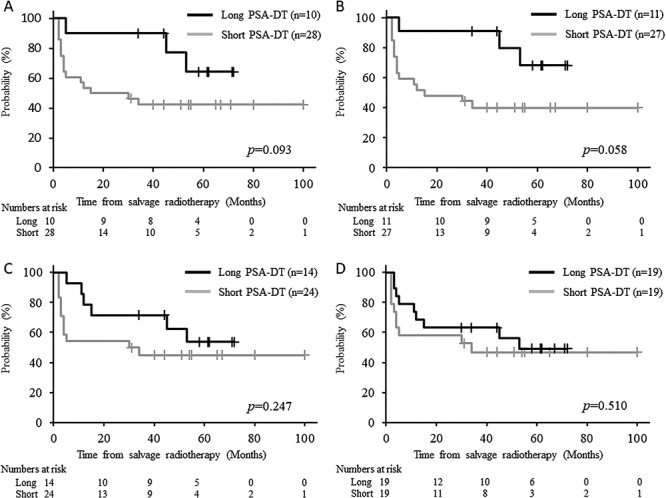
Kaplan–Meier curves of biochemical recurrence-free survival according to different cutoff prostate-specific antigen doubling times (PSA-DTs) before hypofractionated salvage radiotherapy. Cutoff PSA-DT: 14 months (A), 12 months (B), 10 months (C) and 8 months (D).